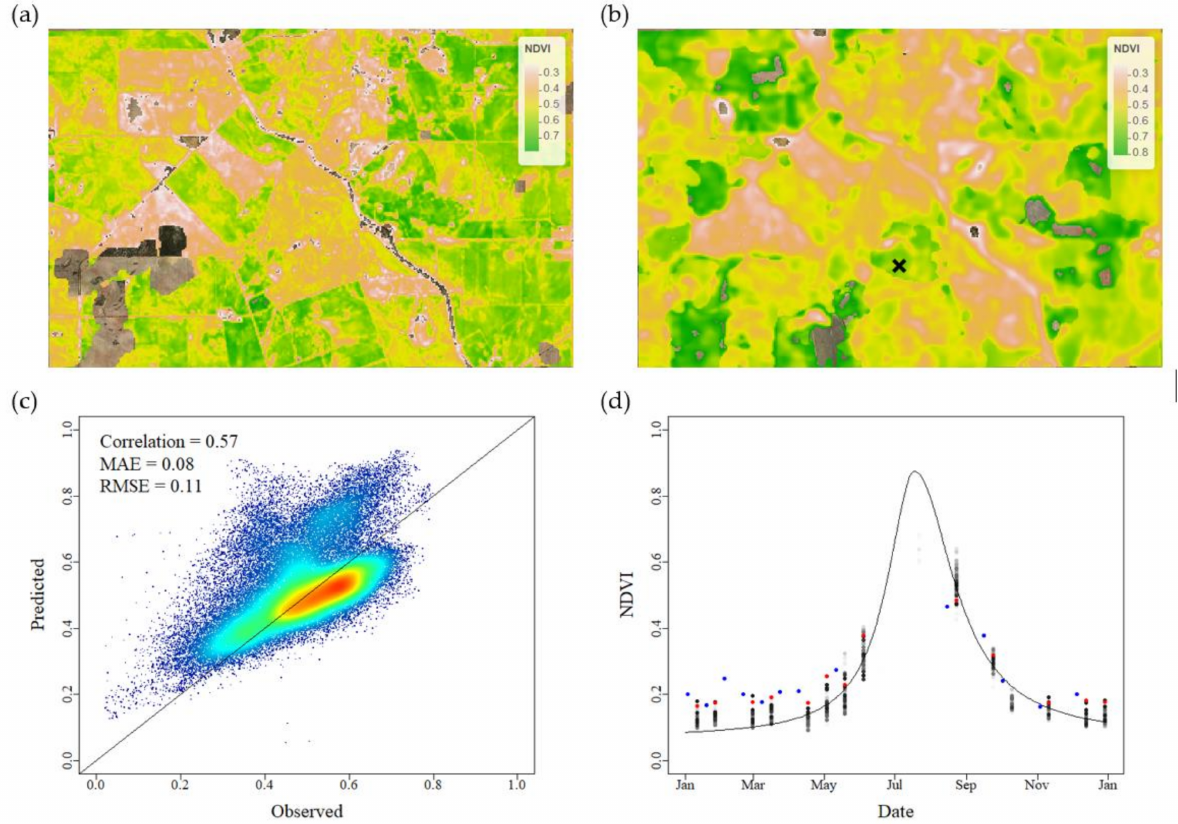
Figure 10. 2014-08-15 Landsat-8 test data: ( a ) observed NDVI; ( b ) predicted NDVI; ( c ) scatterplot of observed versus predicted NDVI coloured by density (red = high, blue = low) with overall accuracy statistics and ( d ) estimated annual growth curve for longitude 118.162, latitude − 31.268 marked by X in ( b ) with the spatially weighted Landsat-7 training data used to estimate the growth curves shown in shades of grey according to their spatial weight (white lowest and black highest, Landsat-7 data for the cell shown in red and Landsat-8 test data shown in